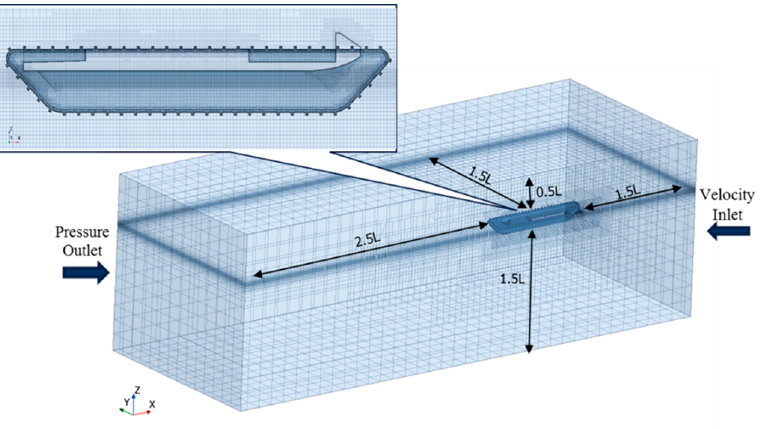
Figure 2. Mesh configuration and computational domain.